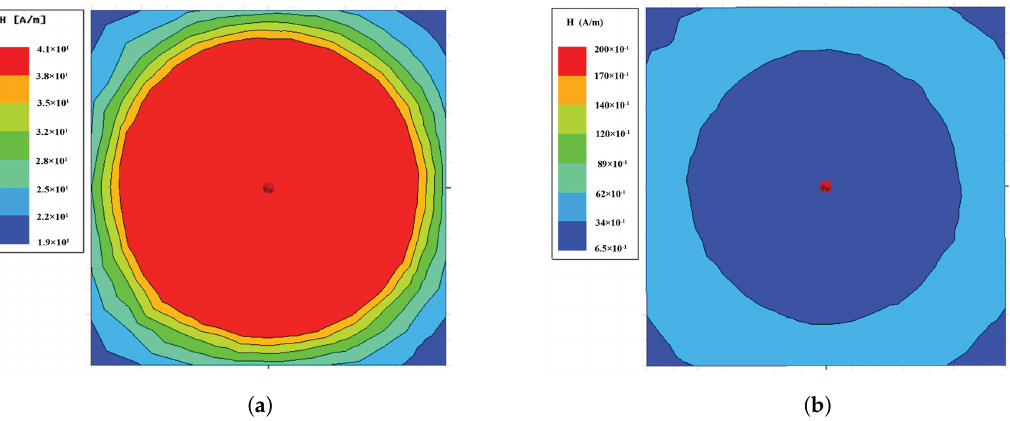
Figure 9. Magnetic field intensity (A/m), ( a ) two coils w/o ferrite core; ( b ) two coils with ferrite